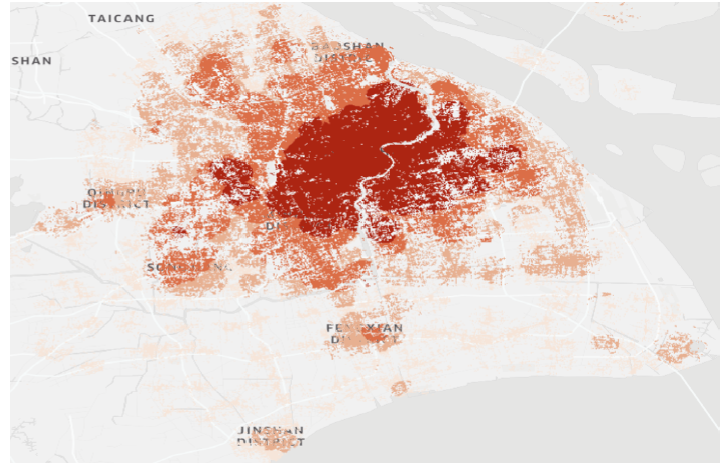
Figure 8. The house price dataset of Shanghai, where red refers to higher house prices.